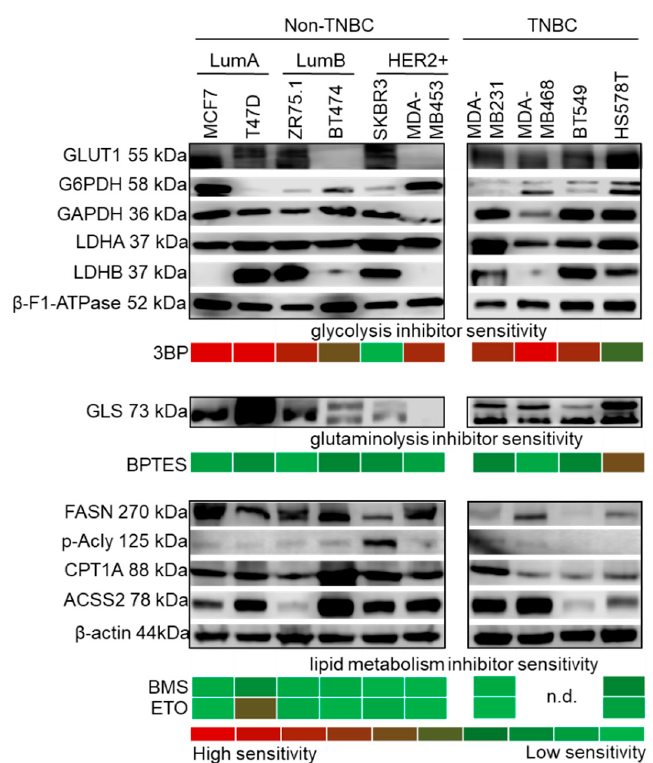
Figure 3. Metabolic characteristics of breast cancer cell lines. Metabolic enzyme expression and inhibitor sensitivity shows individual characteristics in a subtype-independent manner. The upper panel shows representative Western blots of metabolic enzymes indicative of glycolysis and the Warburg effect (GLUT1, G6PDH, GAPDH, LDHA and LDHB), in parallel with 3BP (glycolysis inhibitor, 100 µM) sensitivity. β -F1-ATPase expression was confirmed in all cells. Glutaminase expression (GLS) and the effect of BPTES (GLS1 inhibitor, 10 µM) are shown in the middle panel. The expression of lipid metabolic enzymes (FASN, p-Acly, CPT1A and ACSS2) are shown in the lower panel. The protein profiles of balanced lipid metabolism (with both catabolic and anabolic mechanisms) may account for the resistance to inhibitors of lipid synthesis (BMS, 10 µM) and lipid oxidation (ETO, 50 µM) in the majority of the cell lines. In vitro inhibitor sensitivities are presented with a colour scheme showing inhibitory effects, based on the averages of Alamar Blue and SRB test results: green (0%, resistant cells) to red (~90–100%, highly sensitive cells) (loading control: β -actin.; n.d.: not determined; triple negative breast cancer—TNBC; luminal A—LumA; luminal B—LumB; HER2+ subtypes; inhibitors were tested after 72 h treatment).